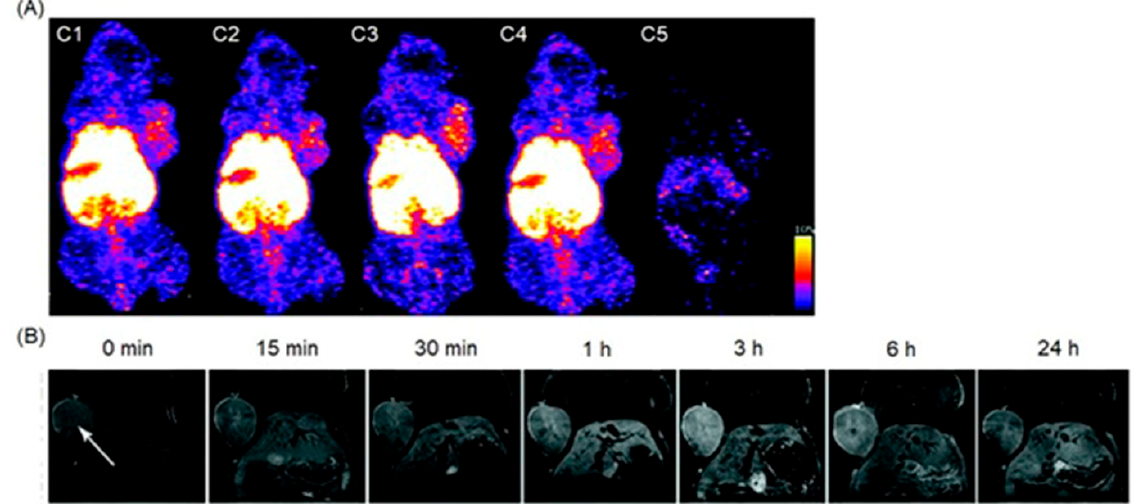
Figure 7. ( A ) SPECT images (C1 through C5) of a tumor-bearing mouse after intravenous admin- istration of 99m Tc-containing MnO x -based mesoporous silica nanoparticles were combined with 99m Tc. The white arrow indicates the region where the tumor is located. ( B ) T images of the tumor-bearing mouse before and after intravenous administration of MnO x -containing mesoporous silica nanoparticles. Adapted with permission of the Royal Society of Chemistry, from 99m Tc-conjugated manganese-based mesoporous silica nanoparticles for SPECT, pH-responsive MRI, and anti-cancer drug delivery, Gao, H.; Liu, X.; Tang, W.; Niu, D.; Zhou, B.; Zhang, H.; Liu, W.; Gu, B.; Zhou, X.; Zheng, Y.; Sun, Y.; Jia, X.; Zhou, L. 8 , 47, 2016 ; permission conveyed through Copyright Clearance Center, Inc.